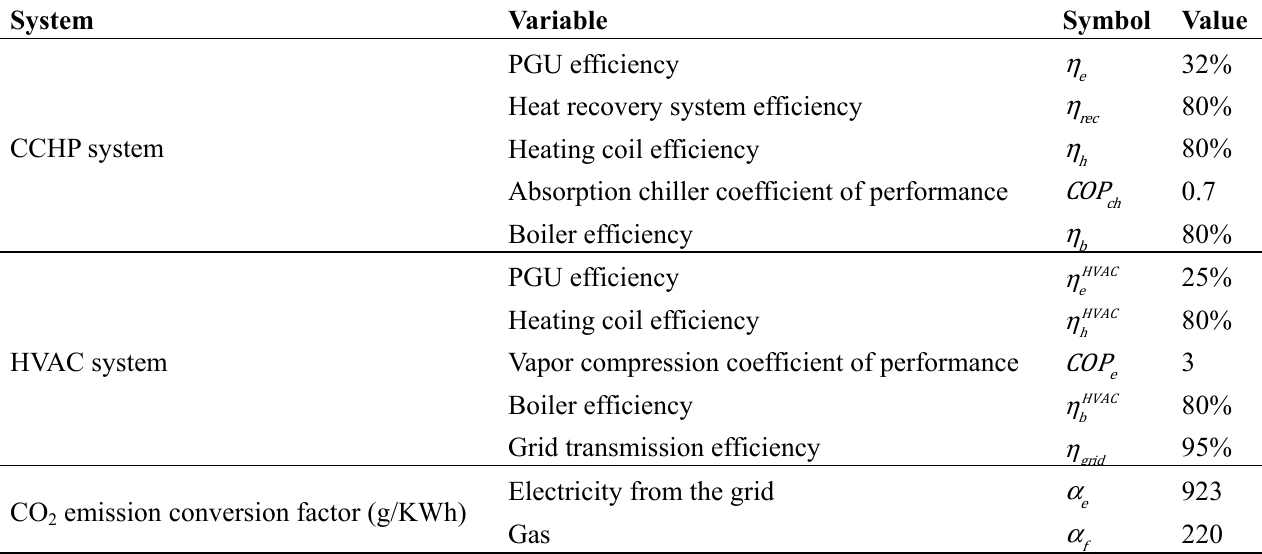
Table 2. Parameters values for CCHP system and HVAC system energy used